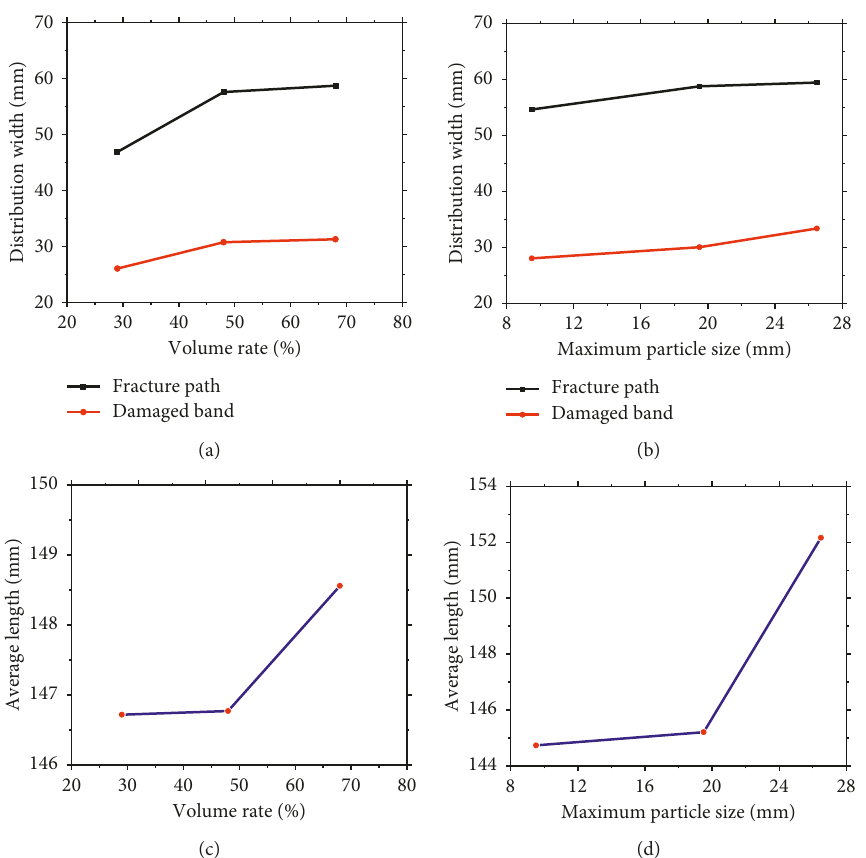
Figure 6: (a) The volume rate, distribution width of the fracture path, and damaged bandwidth; (b) the maximum size, distribution width of the fracture path, and damaged bandwidth; (c) the volume rate and average length of the fracture path; (d) the maximum particle size and average length of the fracture